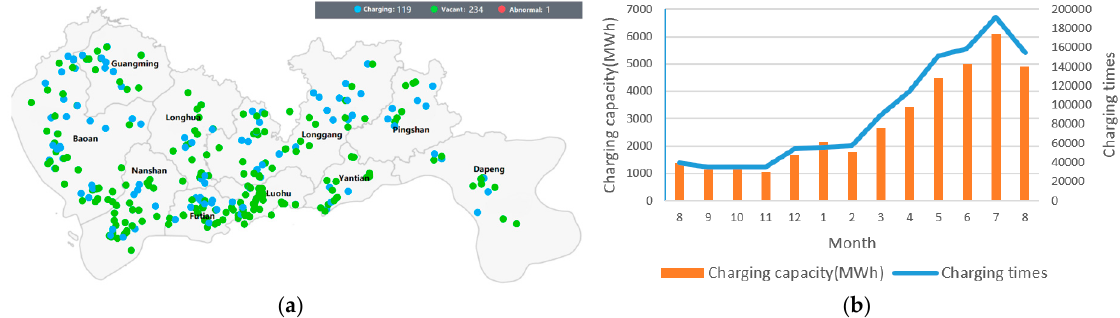
Figure 3. Charging facilities and data in Shenzhen: ( a ) the distribution of charging stations; and ( b ) charging history in Shengzhen.